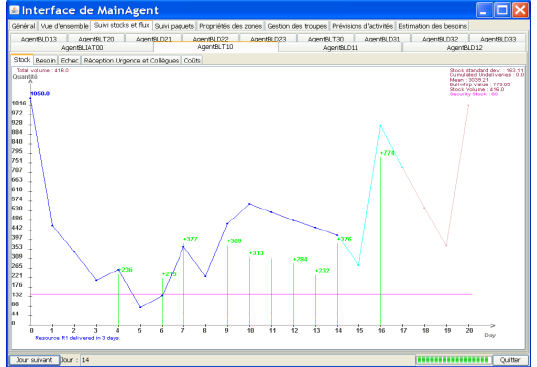
Fig. 10. Stocks evolution for AgZ21 before scheduling